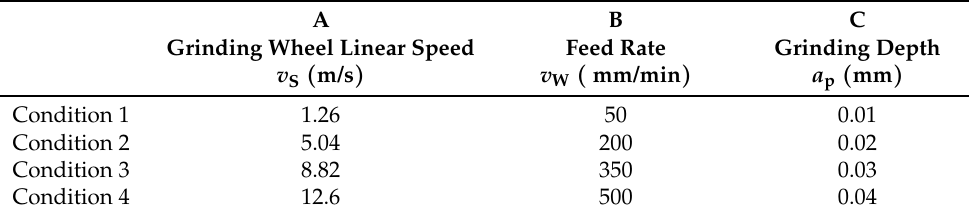
Table 2. C/SiC composite side grinding process parameters ( f = 33.9 kHz,A ≈ 6 µ m).